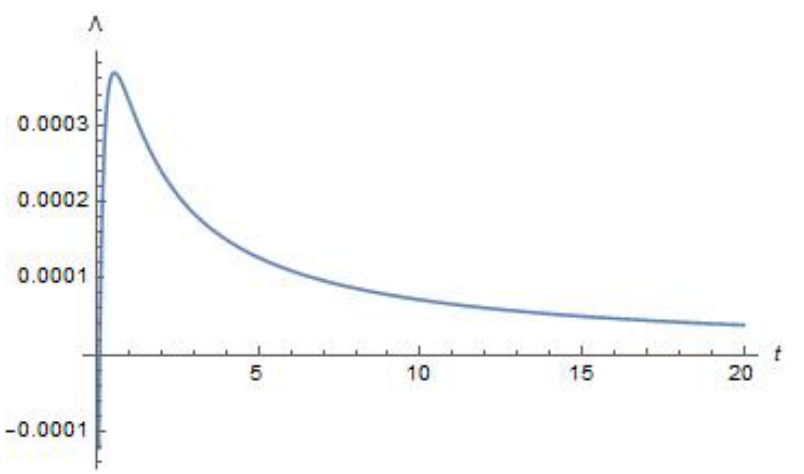
Figure 5. Cosmological parameter Λ (in Gyr − 2 ) against time t (in Gyr ).